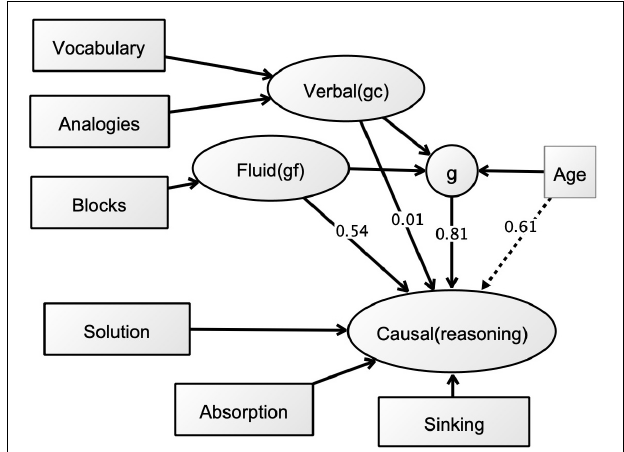
FIGURE 2 | The EQS model investigating the patterns for causal explanatory thinking and general cognitive abilities (path coefficients are shown with numbers on each arrow; straight arrows show direct effects, dotted arrow shows the indirect